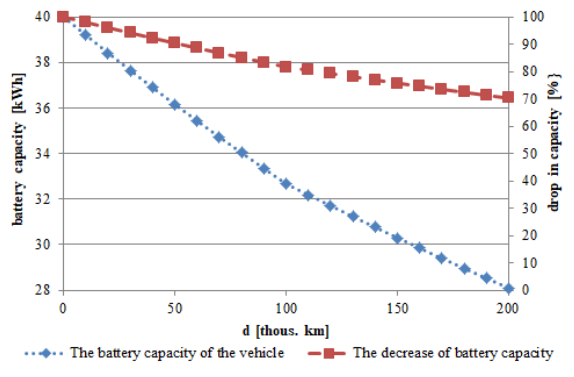
Fig. 2 Battery capacity changes in mileage for Nissan Leaf